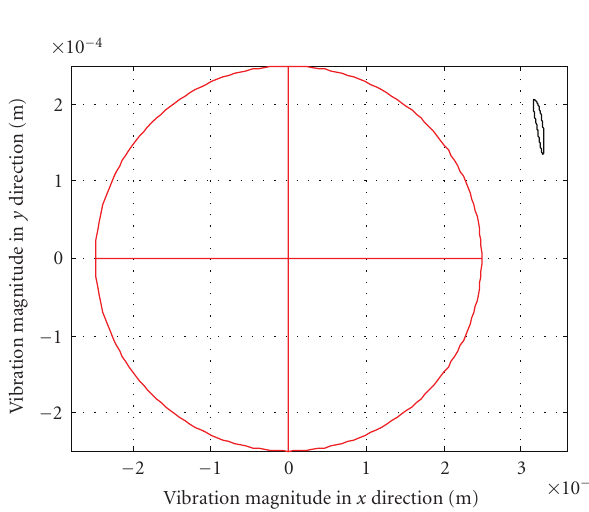
Figure 13: Frequency (0.4mm, 45 ◦ ).